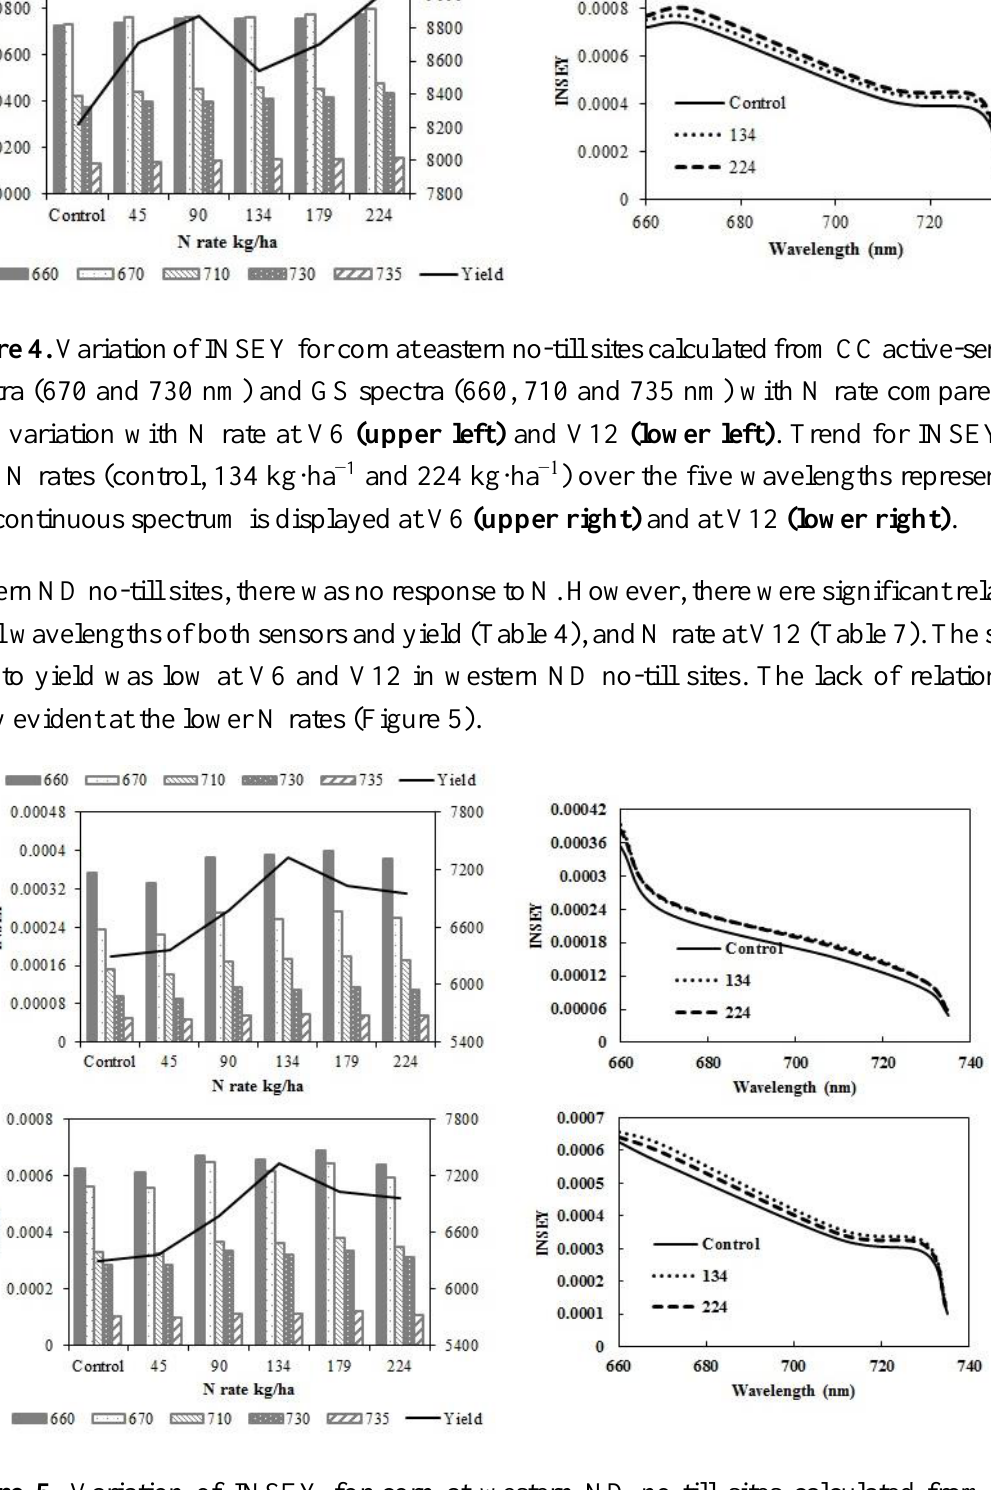
Figure 5. Variation of INSEY for corn at western ND no-till sites calculated from CC active-sensor spectra (670 and 730 nm) and GS spectra (660, 710 and 735 nm) with N rate compared to yield variation with N rate at V6 (upper left) and V12 (lower left) . Trend for INSEY at three N rates (control, 134 kg·ha −1 and 224 kg·ha −1 ) over the five wavelengths represented as a continuous spectrum is displayed at V6 (upper right) and at V12 (lower right)